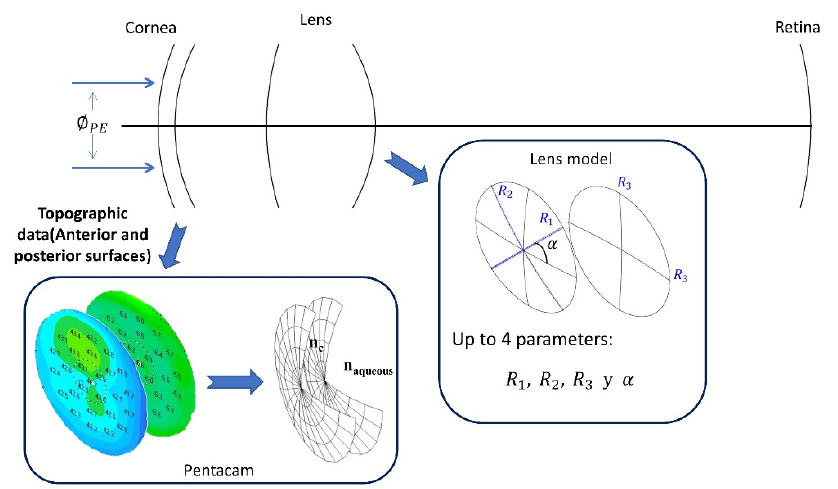
Figure 1. Customized eye model used in